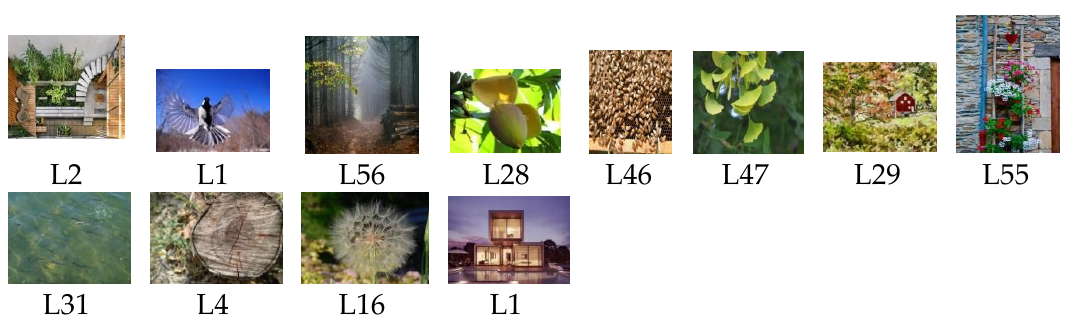
Figure 5. Most recommended pictures with all adjective average values >4.